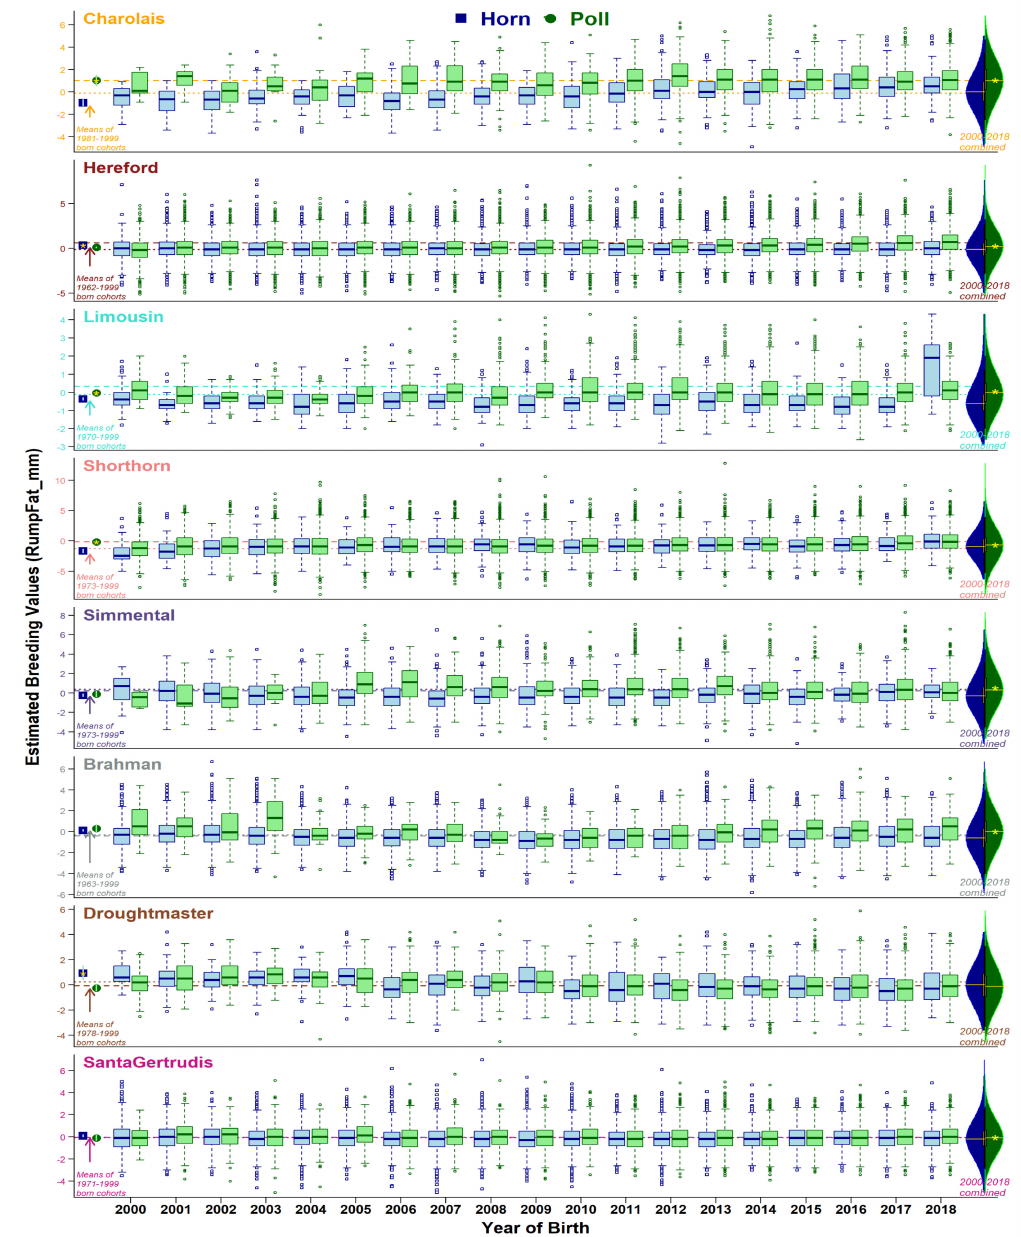
Figure 5. Boxplots of rump fat EBVs (accuracy ≥ 50%) for horn (blue) and poll (green) cohorts born from 2000 to 2018. Dotted and dashed lines show breed averages at the start (2000) and end (2018) of the selected period. Points at the left side of graphs show cohort averages for recorded animals born before 2000. On the right side, violin plots show the distribution of horn and poll cohorts during 2000 to 2018 combined, with a yellow star representing a statistical significance of mean